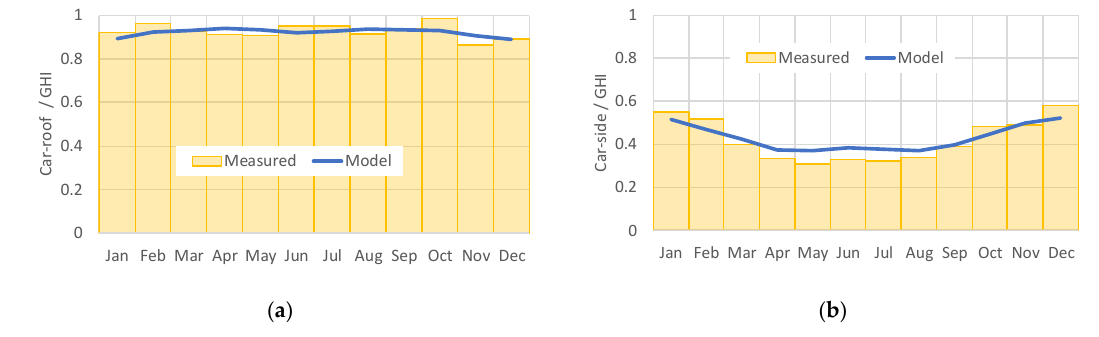
( b ) Figure 16. Daily-based comparison between the measured solar irradiance around the car (blue dots) and modeled (typical year from the METPV-11 solar database) solar irradiance on the car (orange dots): ( a ) car roof irradiance; ( b ) car side irradiance. 3.4. Validation of the Solar Irradiation Model around the Car (Angle)